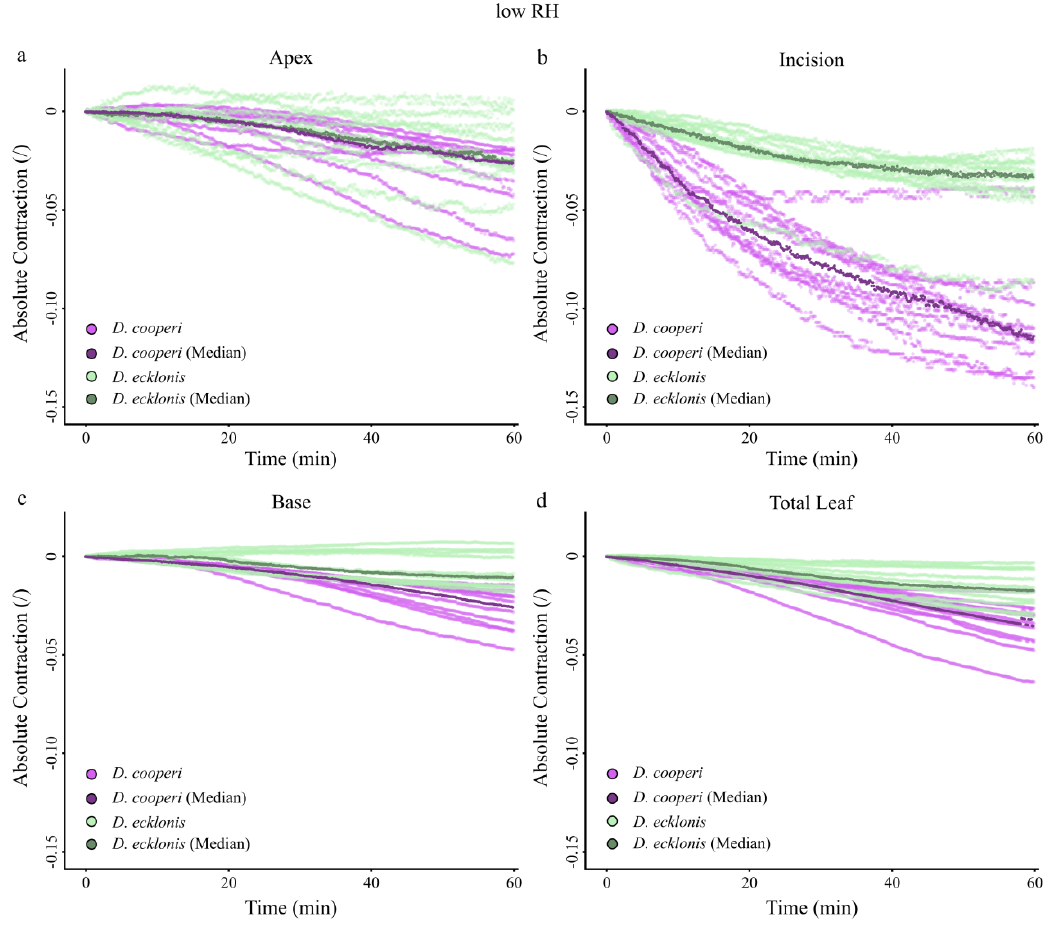
Figure A1. Absolute values of self-sealing kinematics of D. cooperi and D. ecklonis at low relative humidity (RH). Absolute contraction of ( a ) apical leaf segments, ( b ) leaf segments at the incision region, ( c ) basal leaf segments and ( d ) total leaves over time. On average, the relative humidities were 44.0% (IQR: 1.5%) and 43.6% (IQR: 0.9%) for D. cooperi and D. ecklonis , respectively. Each graph depicts the ten individual measurements (light colors) and their corresponding median lines (dark colors) for both D. cooperi (purple curves) and D. ecklonis (green curves).